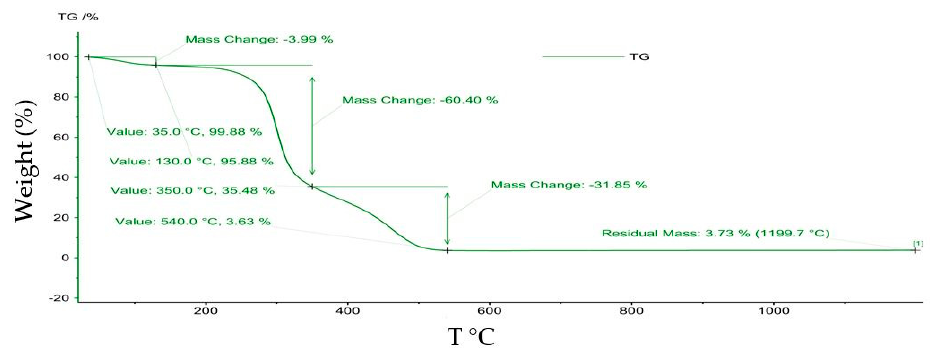
Figure 9. TG curve of maize stalk after adsorption Figure 9 . TG curve of maize stalk after adsorption process. Figure 9 . TG curve of maize stalk after adsorption process. Table 7. Thermal weight loss for maize stalk before and after adsorption. Table 7. Thermal weight loss for maize stalk before and after adsorption.